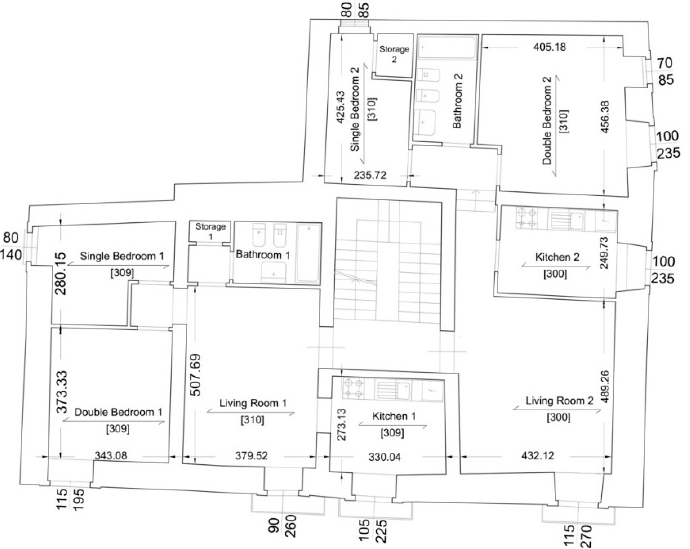
Figure 2. Typical floorplan of the selected building.